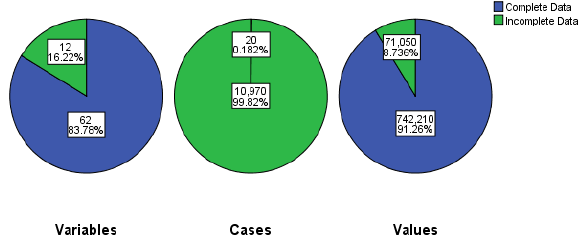
Figure 4. Distribution of complete and incomplete data in the variables, cases and values.